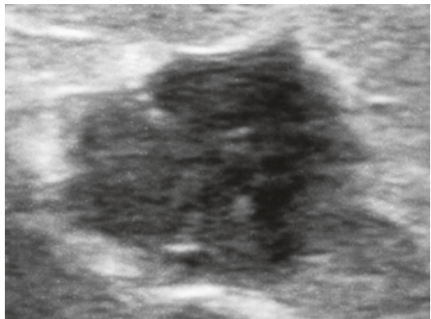
Figure 1: Ultrasound examination of the axillary mass reveals a hypoechoic mass with irregular margins.